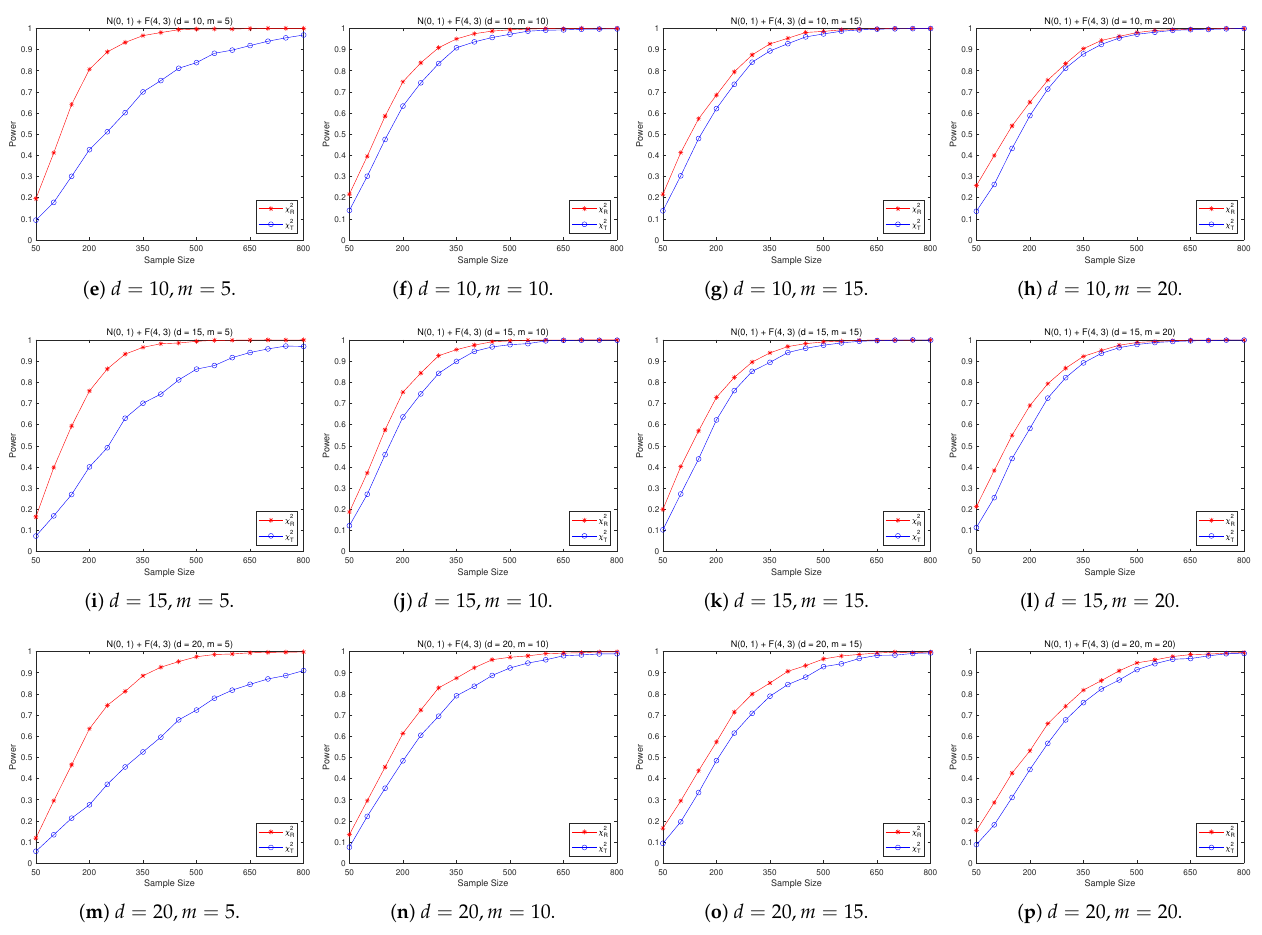
Figure 9. The distribution N ( 0,1 ) + F ( 4,3 ) . Red line for RP-chi-square, blue line for traditional